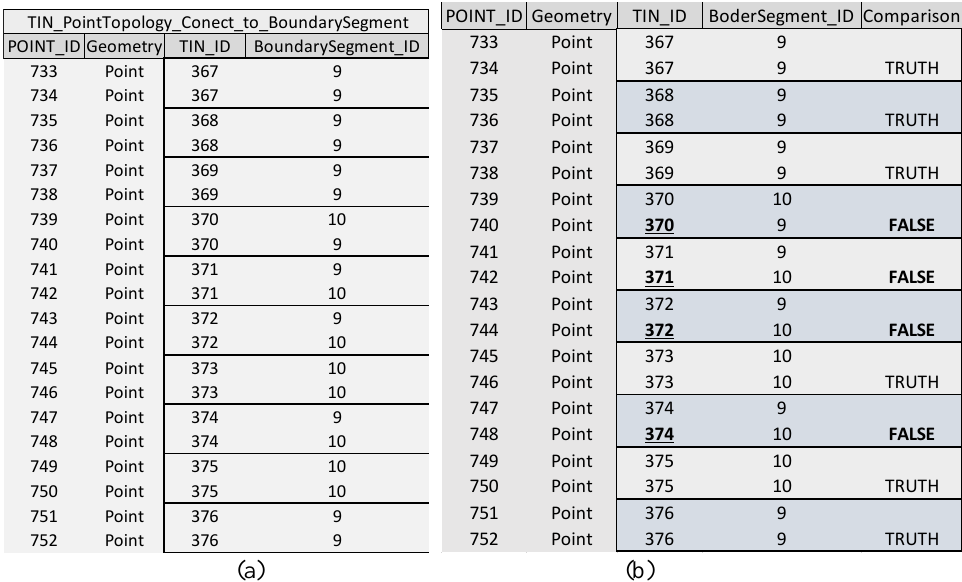
Figure 4. Selection of TIN edges (TIN_ID) based o: ( a ) attributes of TIN vertices based on the topological relations during data processing; ( b ) ID of TIN edges selected based on FALSE values (370, 371, 372, 374, etc.).